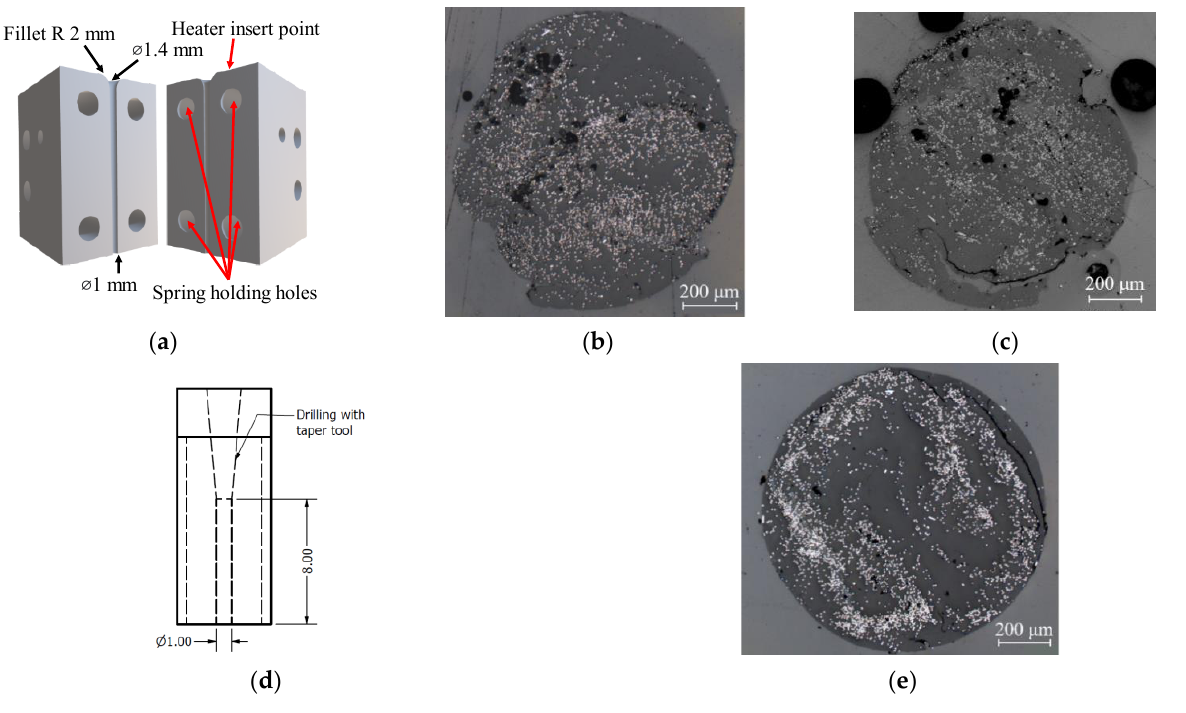
Figure 3. ( a ) A schematic of a two-side assembly convergent nozzle; ( b , c ) circular filament after passing through the two-side convergent nozzle; ( d ) the cross section of final pultrusion nozzle; ( e ) the final perfect circular cross section filament.